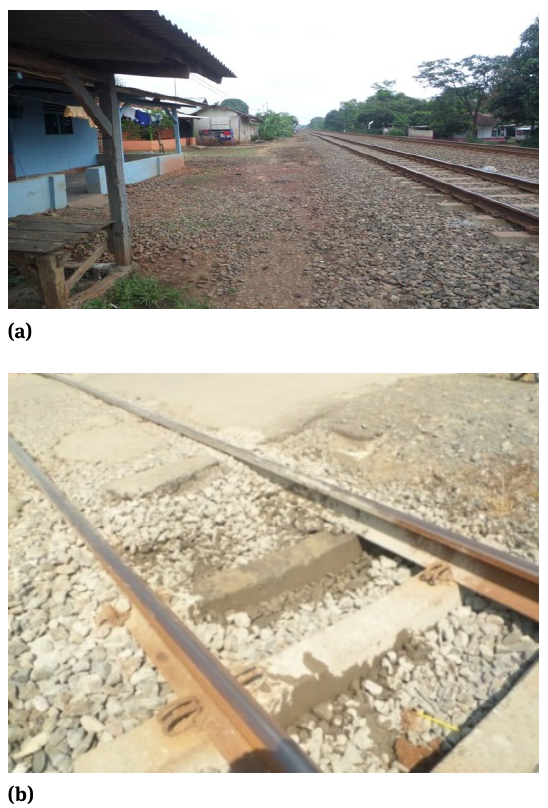
Figure 1: (a) Ballast deformation; (b) mud pumping.